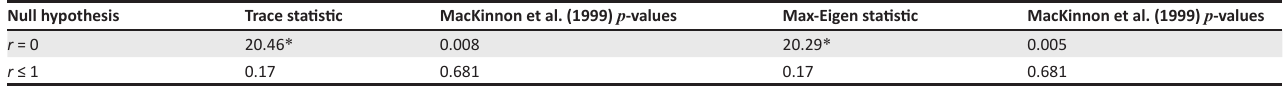
TABLE 8: JJ co-integration